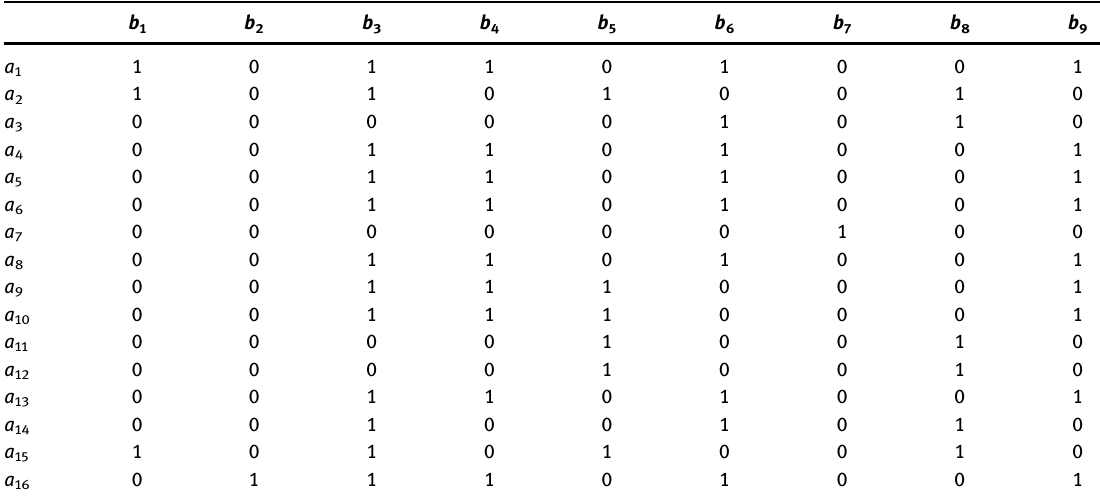
Table 1: Characteristics codes of the defensive glands of 16 genera of